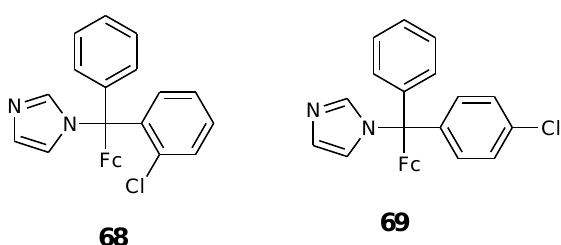
Figure 23. Chemical structures of ferrocenyl- clotrimazole derivatives ( 68 – 69 ).